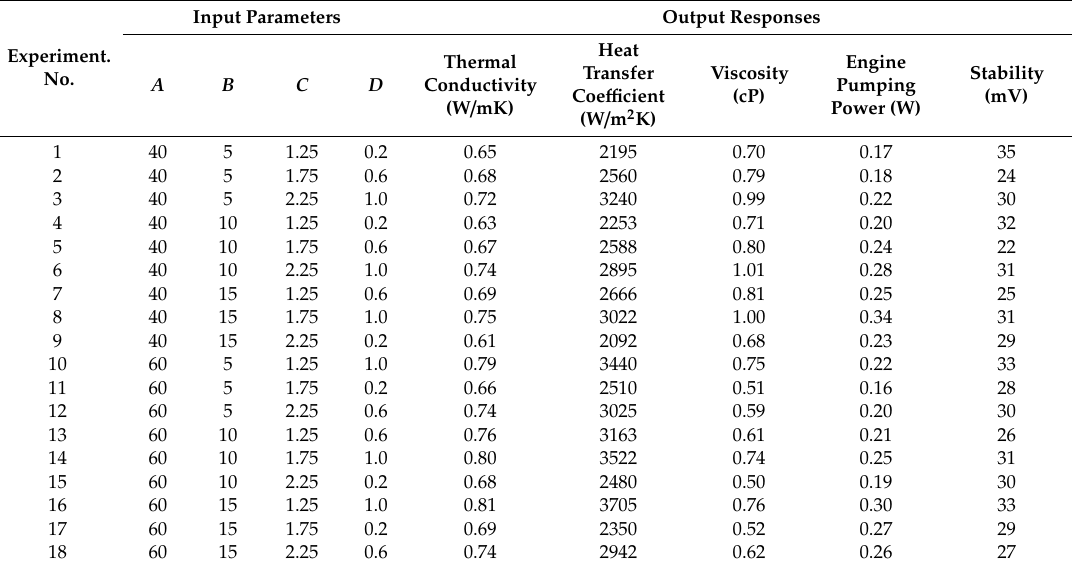
Table 3. L 18 orthogonal array (OA) along with values of output responses.